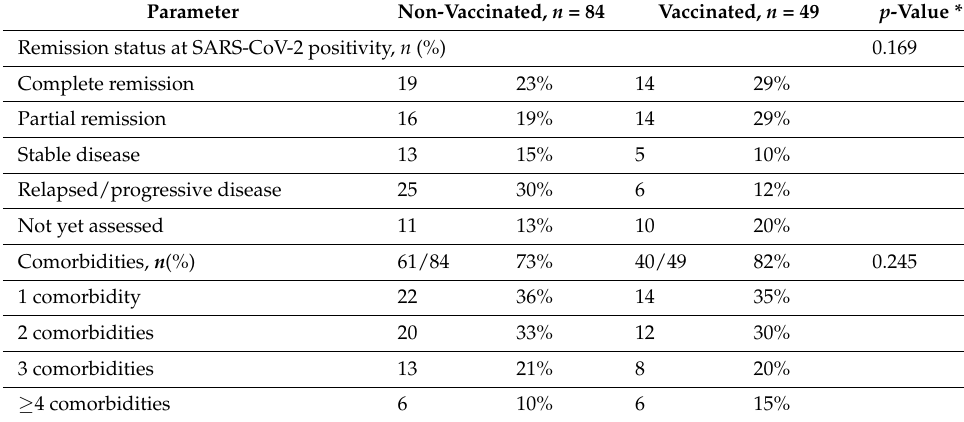
Table 1. Cont. Parameter Non-Vaccinated, n =